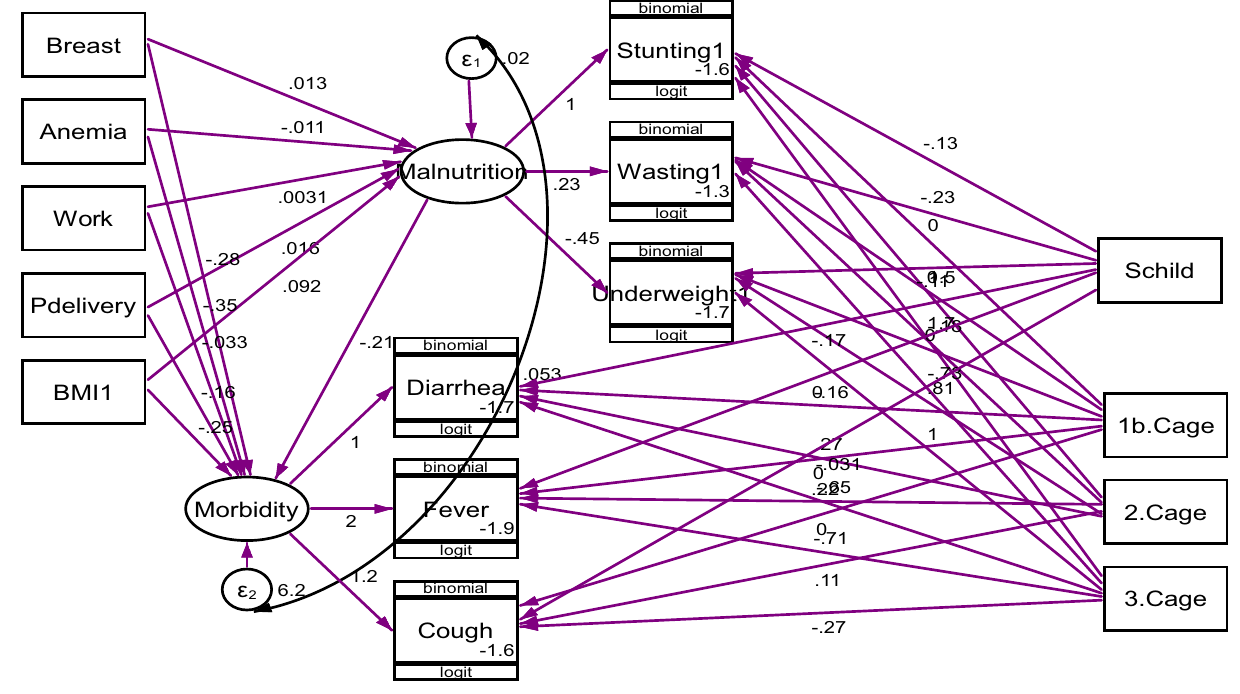
Figure 2. Generalized structural equation model of effects of selected covariates on latent variables malnutrition and morbidity and observed